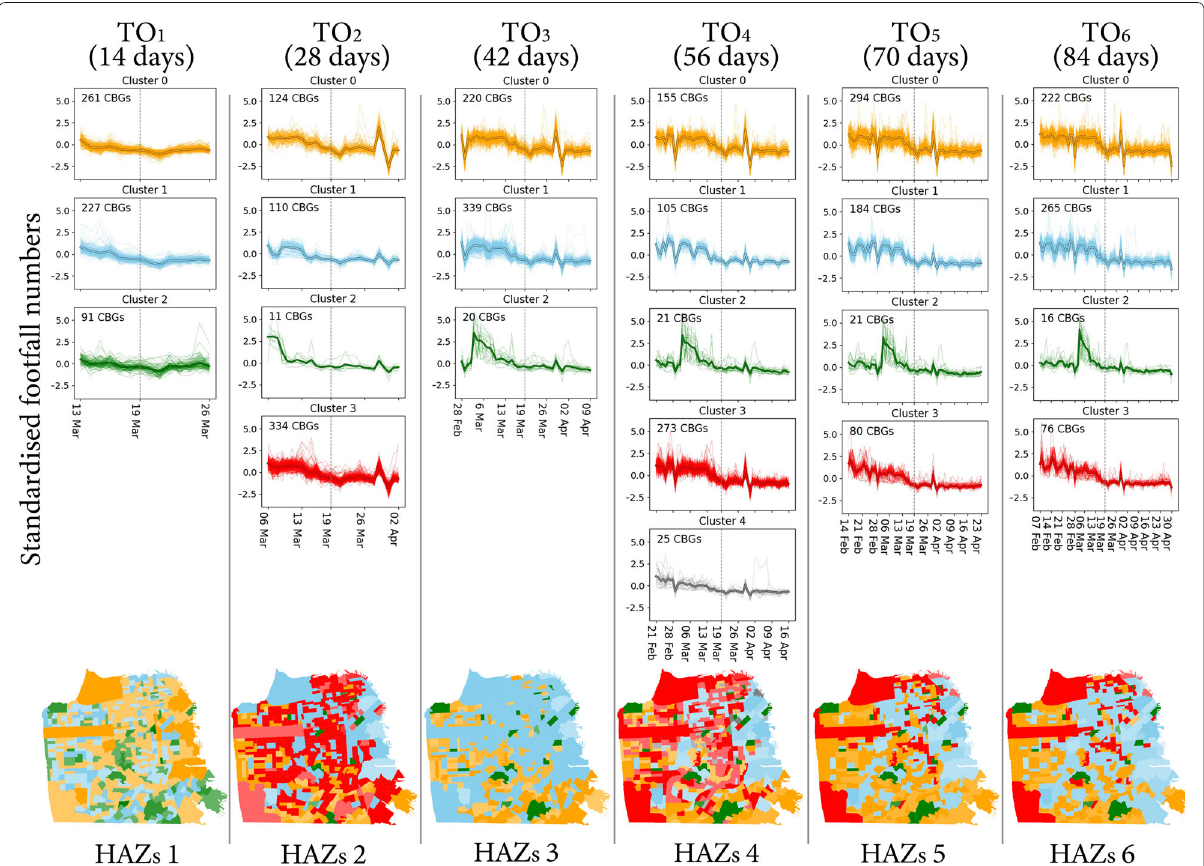
Fig. 2 Clustering of temporal footfall patterns (top) and the corresponding human activity zones (bottom). The first-level clusters of temporal footfall patterns are illustrated as colored signatures for each TO. The bold center line for each signature cluster denotes its variation characteristic of human activities; Second-level clusters are distinguished by the color saturation in each map of human activity zones. Then, the HAZs in each TO are generated by the combination of first-level characterized by human activity pattern and second-level characterized by human activity volume with total zone numbers (m1 x m2), i.e., 9 (3 × 3), 12 (4 × 3), 9 (3 × 3), 15 (5 × 3), 12 (4 × 3), 12 (4 ×